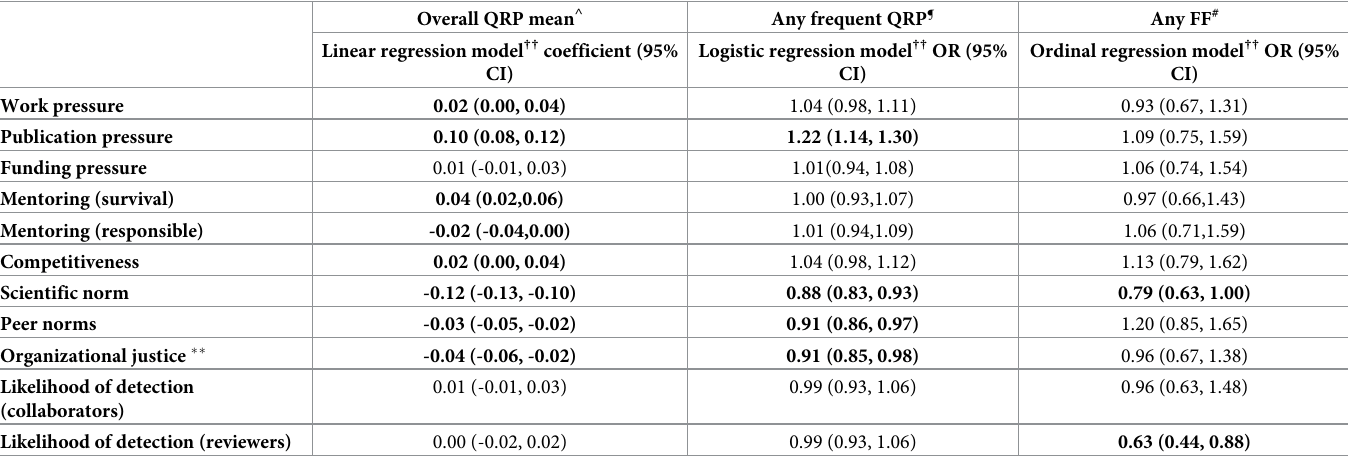
Table 4. Regression coefficients and odds ratios (95% confidence interval) of overall QRP mean, any frequent QRP and any FF stratified by explanatory factor